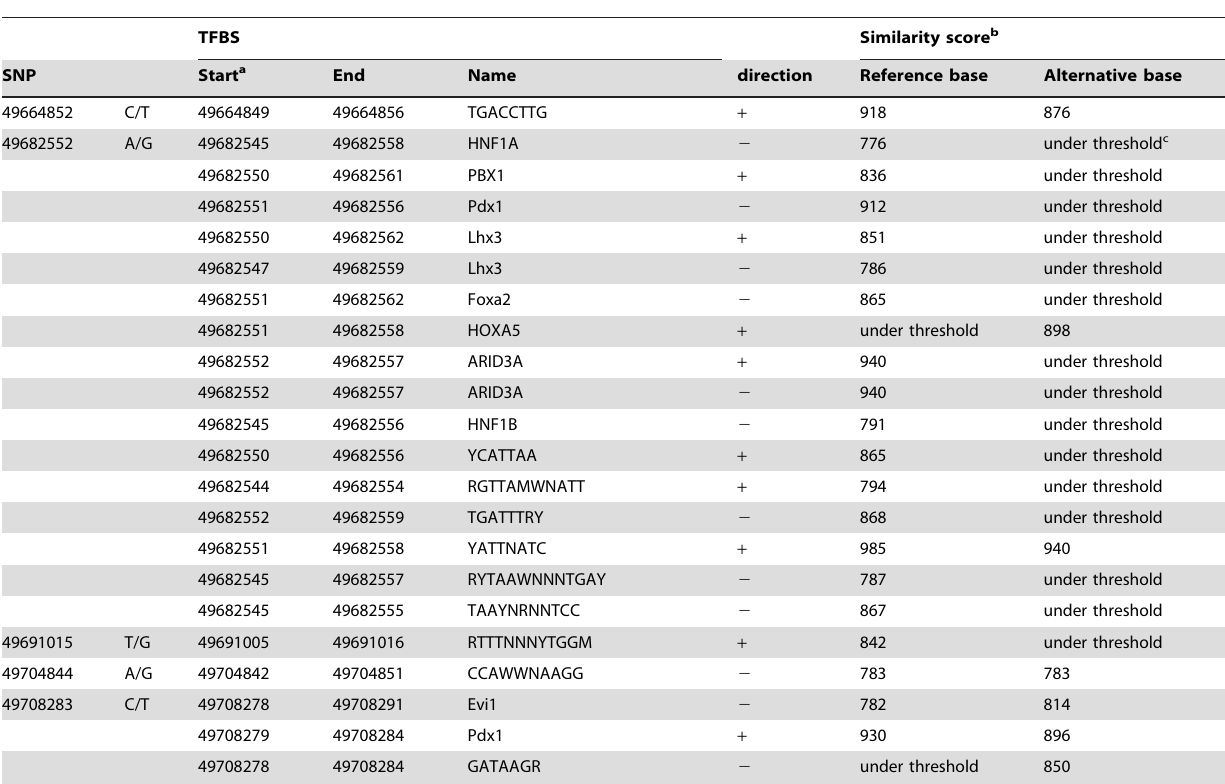
Table 2. Predicted TFBS that are affected by targeted Weaver